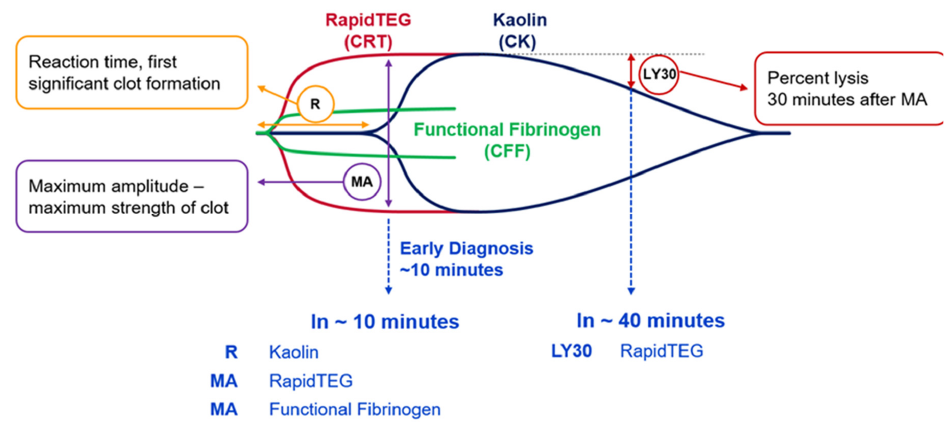
Figure 1. Thromboelastography (TEG) measurements shown in graphical format explaining the results of the relevant areas of the curve. LY30: Hyperfibrinolysis after 30 min suggests the stability of the clot formed; MA: maximum amplitude is suggestive of the strength of the clot formed; R: reaction time and length of time taken to initiate clot formation.